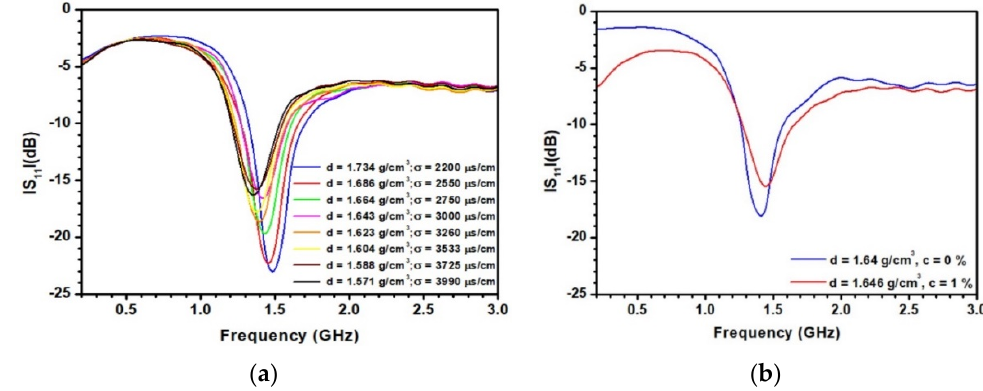
Figure 9. ( a ) Variation of the S 11 parameter as a function of the frequency for a concentration c = 0.5 %; ( b ) resonances measured at (d = 1.640 g / cm 3 , c = 0 %) and (d = 1.646 g / cm 3 , c = 1 %).